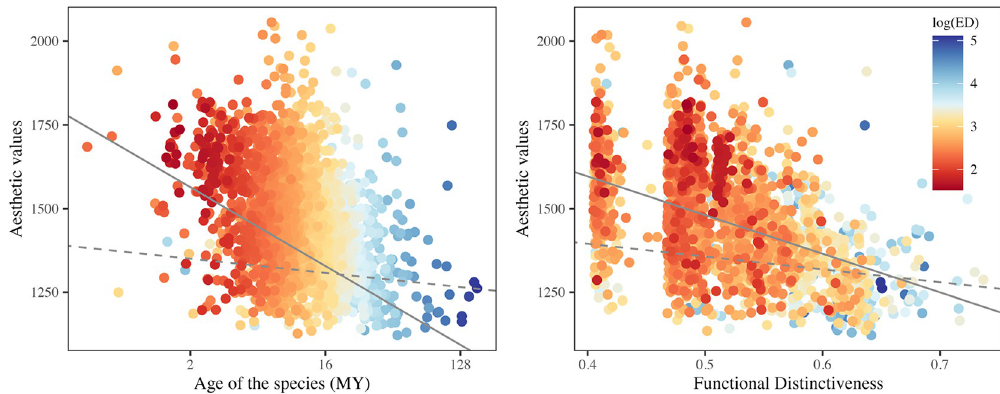
Fig 3. Phylogenetic history and ecological originality. (a) Relationship between the aesthetic value and the age of the species (log transformed) in millions of years (averaged over 100 trees) without (plain line) and after (dashed line) accounting for phylogenetic relatedness. Both models show significant negative slopes (considering phylogenetic relatedness: slope = − 78.4, p -value < 0.001; not considering phylogenetic relatedness: slope = − 14.1 ± SD 1.7, p -value < 0.005, over the 100 random trees). (b) Relationship between the aesthetic value and the functional distinctiveness of species without (plain line) and after (dashed line) accounting for phylogenetic relatedness. Both models show significant negative slopes (considering phylogenetic relatedness: slope = − 1,154.2, p -value < 0.001; not considering phylogenetic relatedness: slope = − 383.3 ± SD 26.5, p -value < 0.001, over the 100 random trees). On both panels, species’ Evolutionary Distinctiveness (averaged over 100 trees and log transformed) have been used to color the points from low (dark red) to high (dark blue) values. Data and code required to generate this Figure can be found in